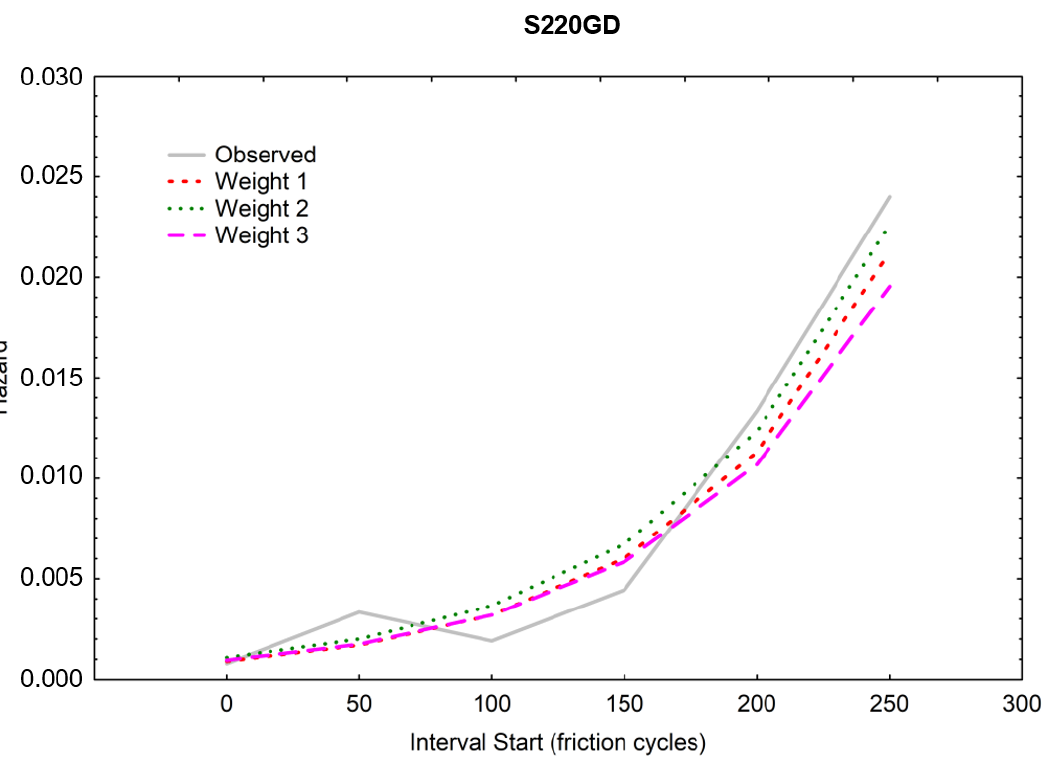
Figure 18. Hazard function for the S220GD sheet metal (“white”).